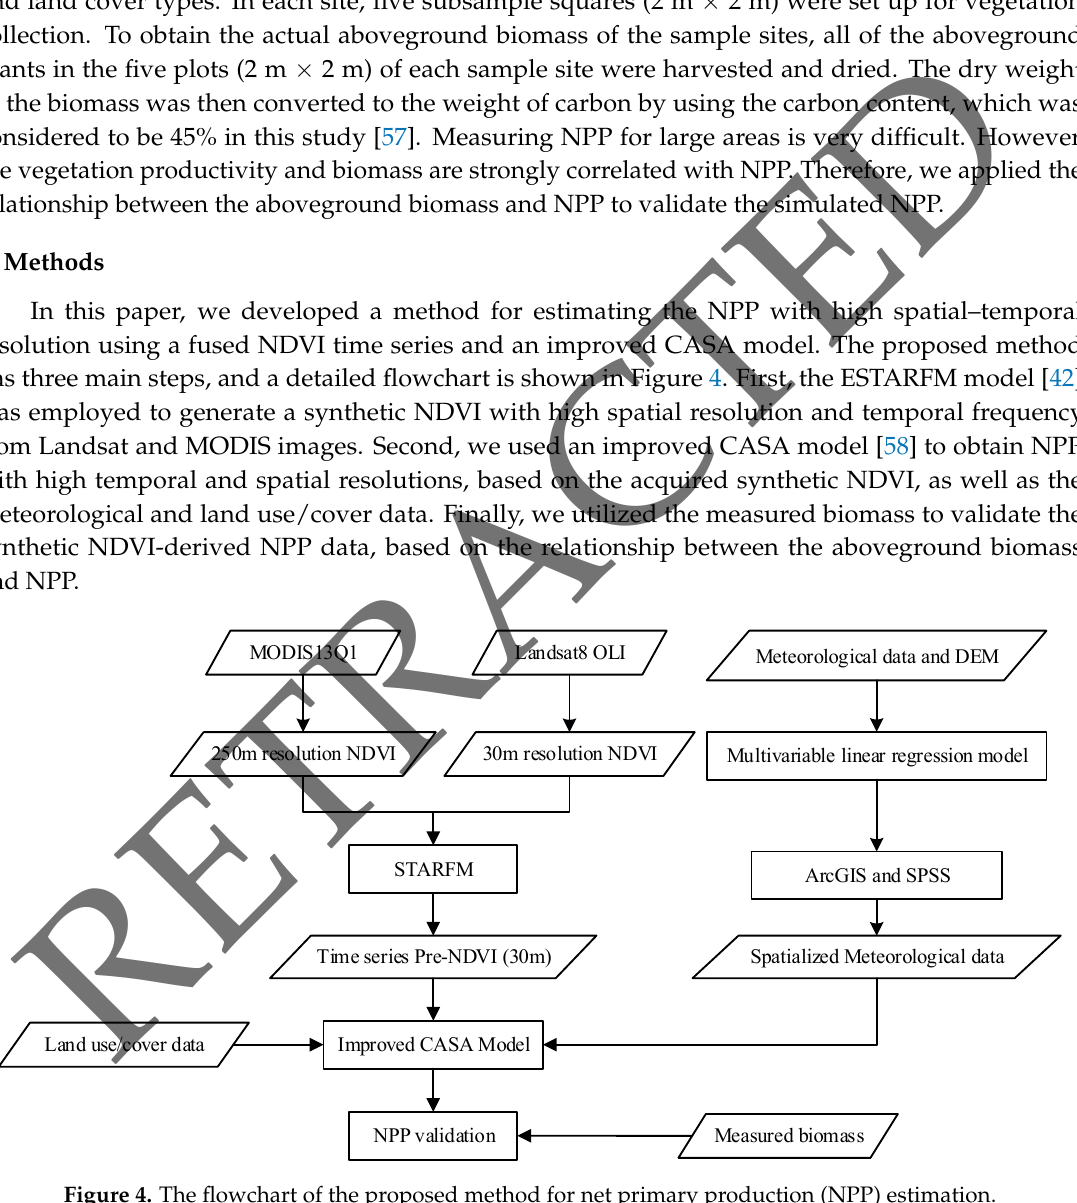
Figure 4. The flowchart of the proposed method for net primary production (NPP) estimation.